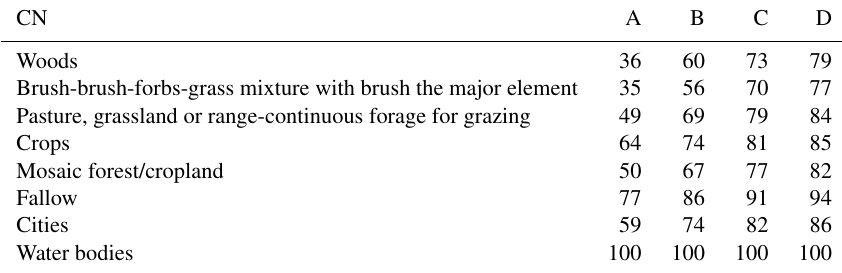
Table A5. CN for CN land cover classes and Hydrologic Soil Groups.